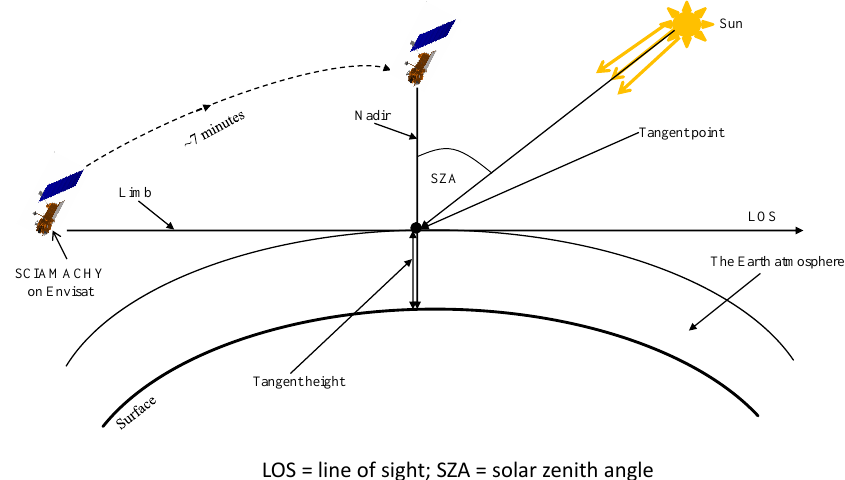
Figure 1. Illustration of SCIAMACHY limb and nadir observation geometries.